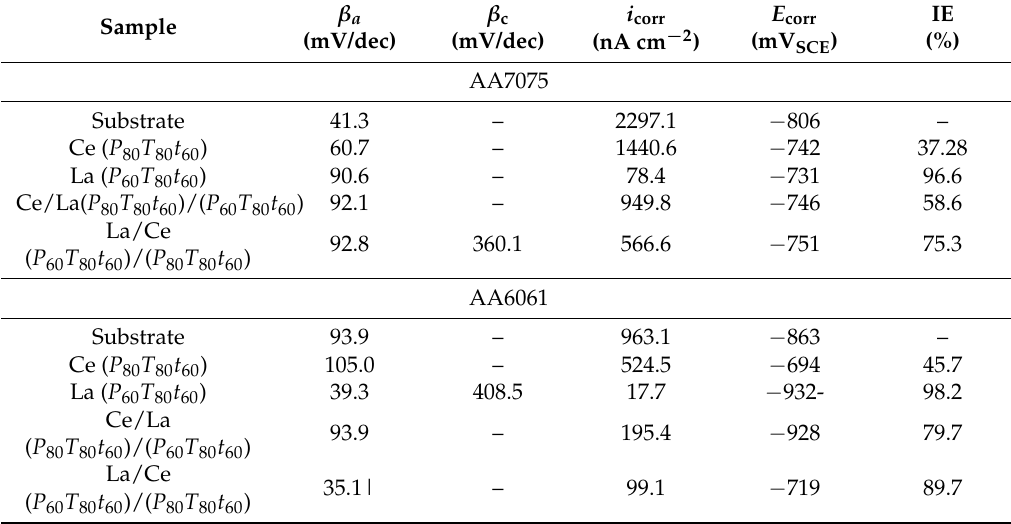
Table 3. E corr , i corr and corrosion rate calculated from the potentiodynamic